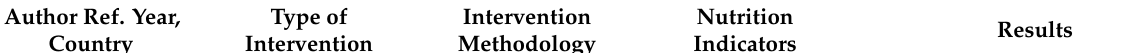
Table 1. Main results of nutrition education programs for African